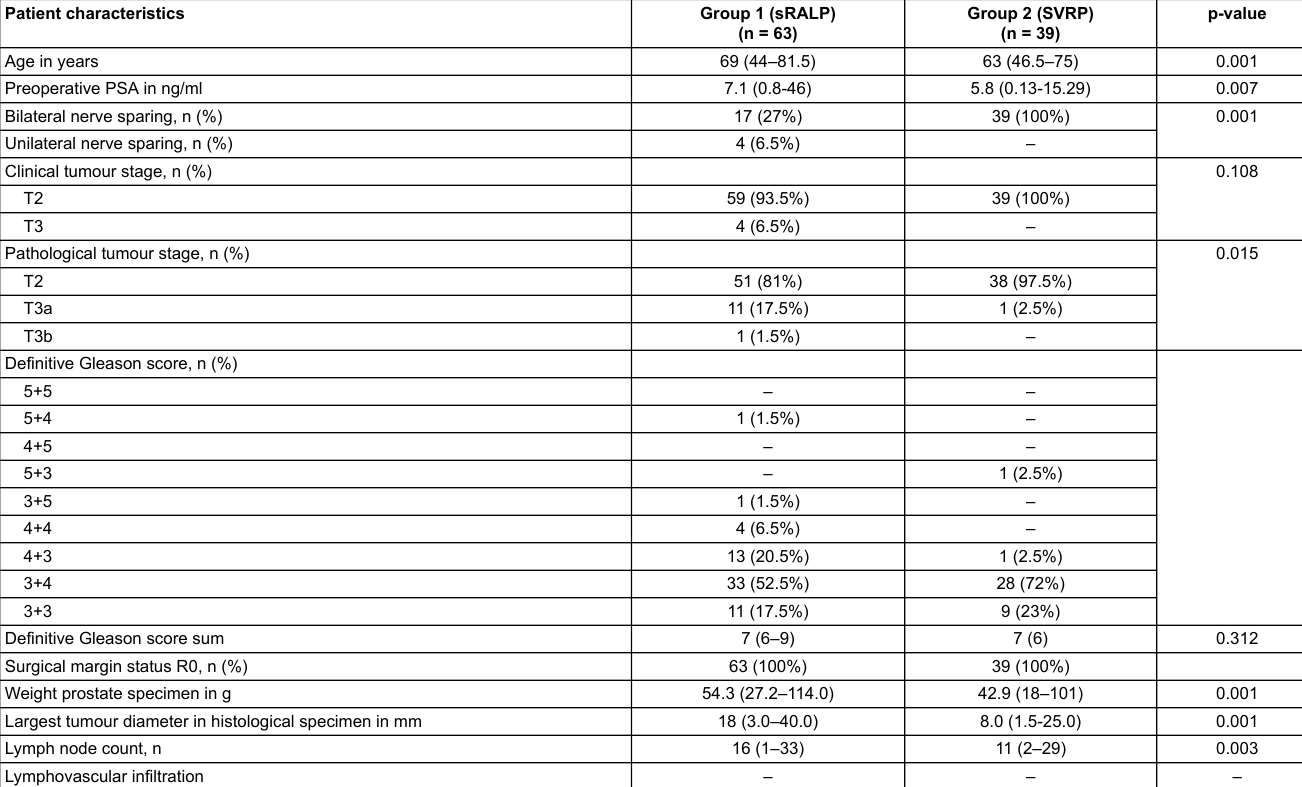
Table 1: Clinical and pathological characteristics of the 102 patients.